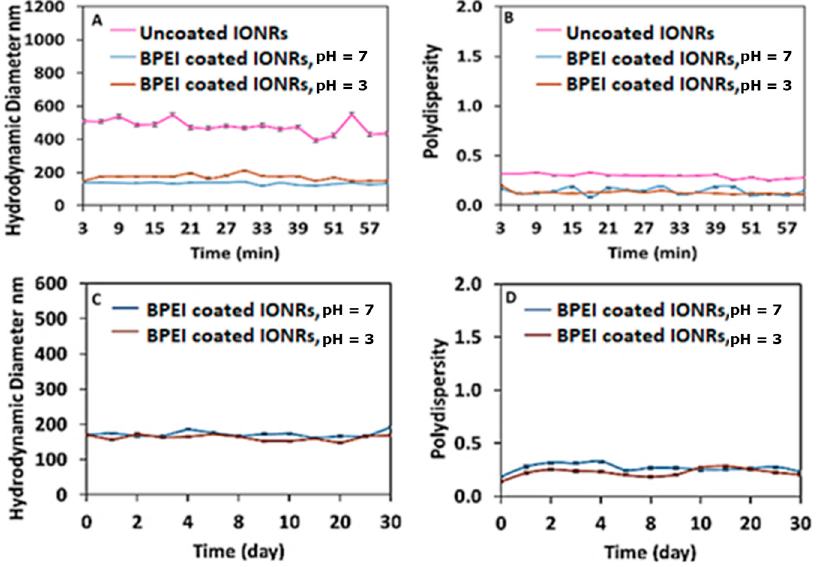
Figure 4. Colloidal stability studies via DLS measurements room temperature: ( A ) hydrodynamic diameter of uncoated IONR at pH 7 (pink), IONR capped with BPEI at pH 7 (blue) and IONR capped with BPEI at pH3 (brown) over one hour; ( B ) hydrodynamic diameter polydispersity of uncoated IONR at pH 7 (pink), IONR capped with BPEI at pH7 (blue) and IONR capped with BPEI at pH 3 (brown) over one hour; ( C ) hydrodynamic diameter of IONR capped with BPEI at pH 7 (blue) and IONR capped with BPEI at pH 3 (brown) over one month; ( D ) hydrodynamic diameter polydispersity of IONR capped with BPEI at pH 7 (blue) and IONR capped with BPEI at pH 3 (brown) over one month. All measurements are the average of 60 readings repeated 3 times over 3 min.